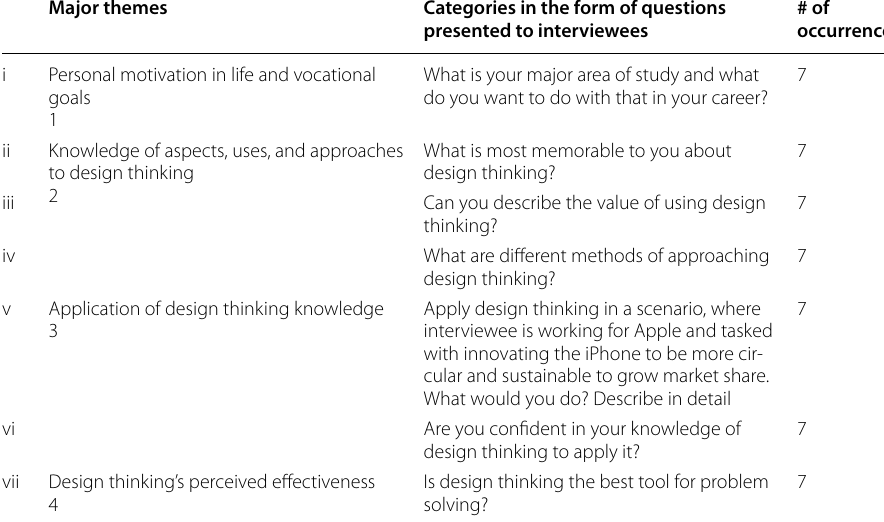
Table 2 Interview codification with four major themes and seven categories that correspond to lines of questioning in the interview protocol (Appendix